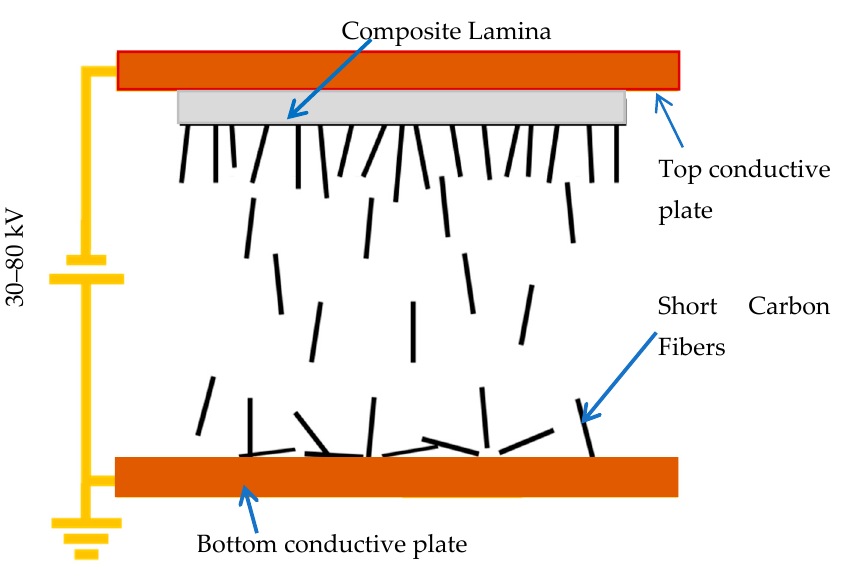
Figure 1. Schematic of wet electro-flocking method.